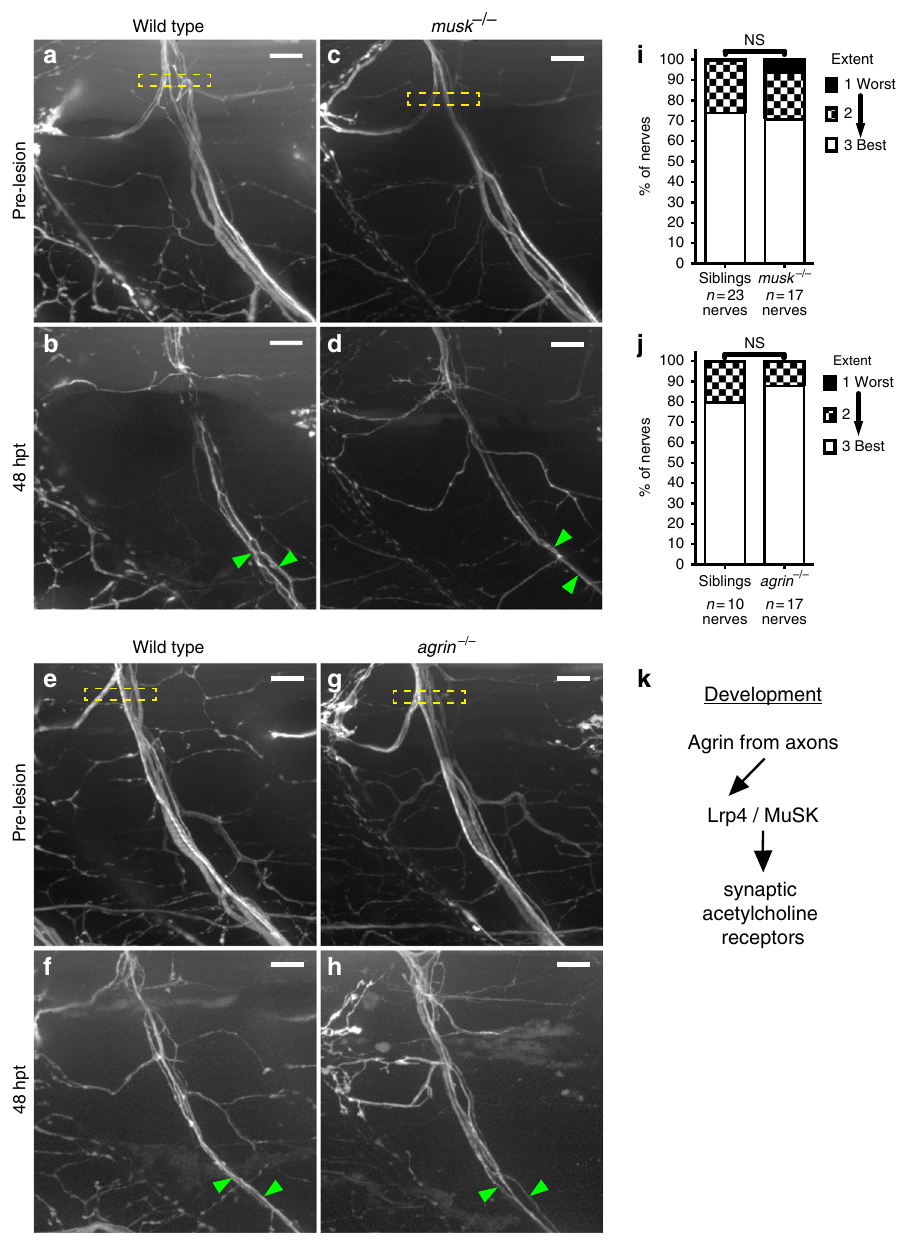
Fig. 4 lrp4 acts in a MuSK-independent pathway to promote axonal regeneration. a Lateral view of wild-type GFP-labeled motor nerve before laser transection at 5 dpf. Yellow dashed box indicates transection site, scale bar is 10 µ m. b Forty-eight hours post transection, multiple axon fascicles